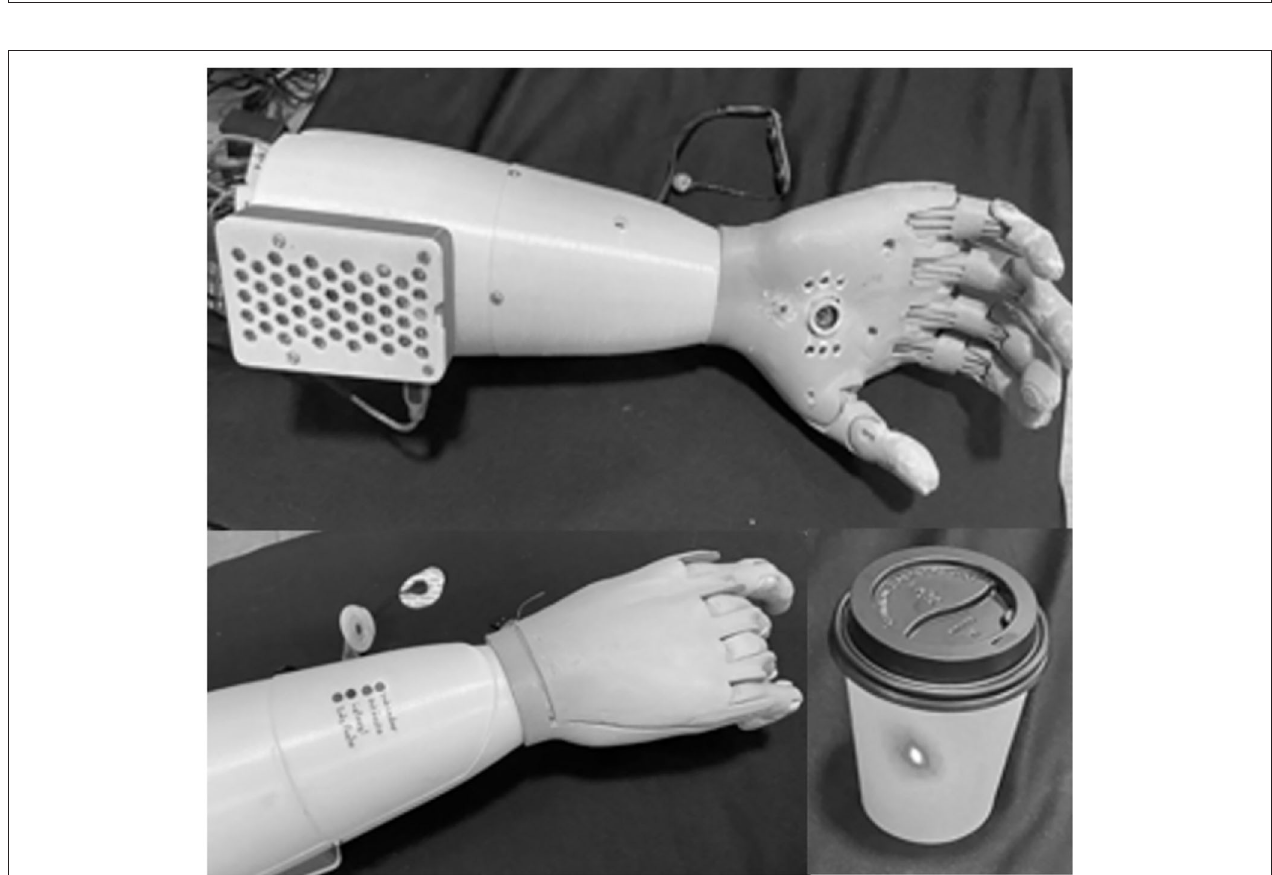
FIGURE 2 | 3D prosthesis prototype with the camera, laser point, and LEDs.